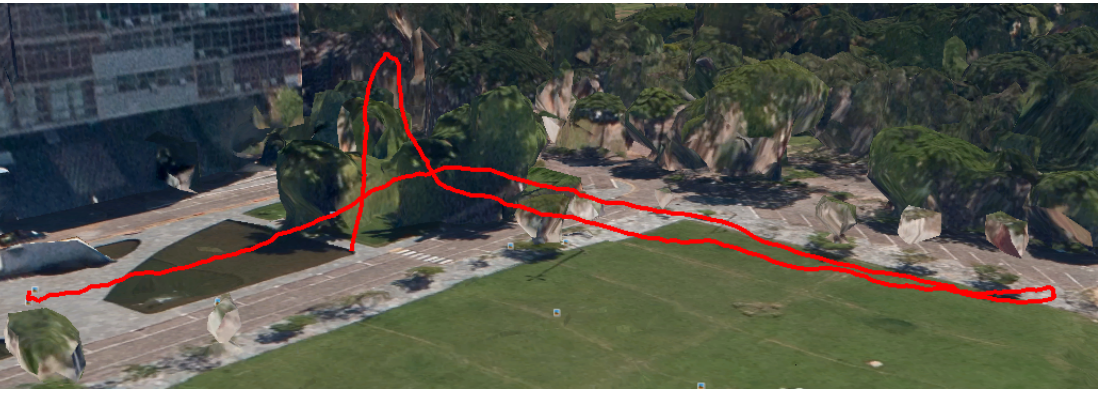
Figure 13. Autonomous flight path.